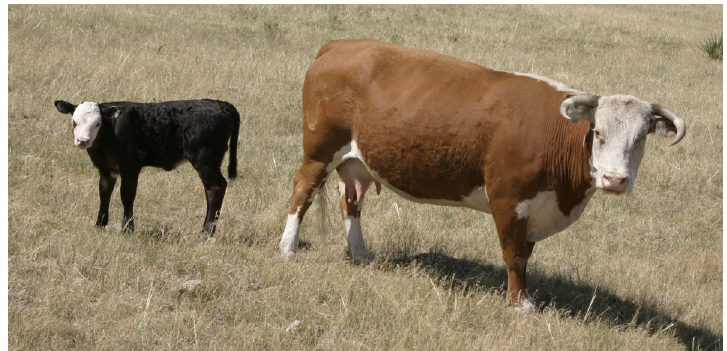
Figure 23. Hereford cow with black baldy calf on the plains, Nebraska, 2007 (photograph Marleen